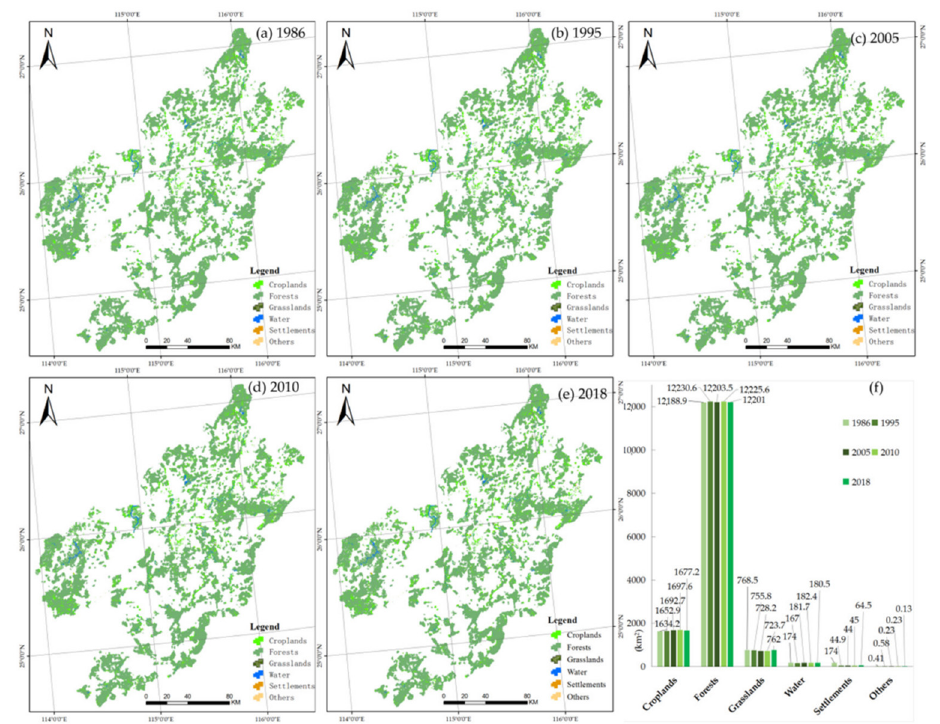
Figure 2. Landscape ecological-type maps of the ERL in the UR-GJ. Figures ( a – e ) are the maps of landscape ecological types in 1986, 1995, 2005, 2010, and 2018, respectively; ( f ) is the area histogram of landscape ecological types in 1986–2018.